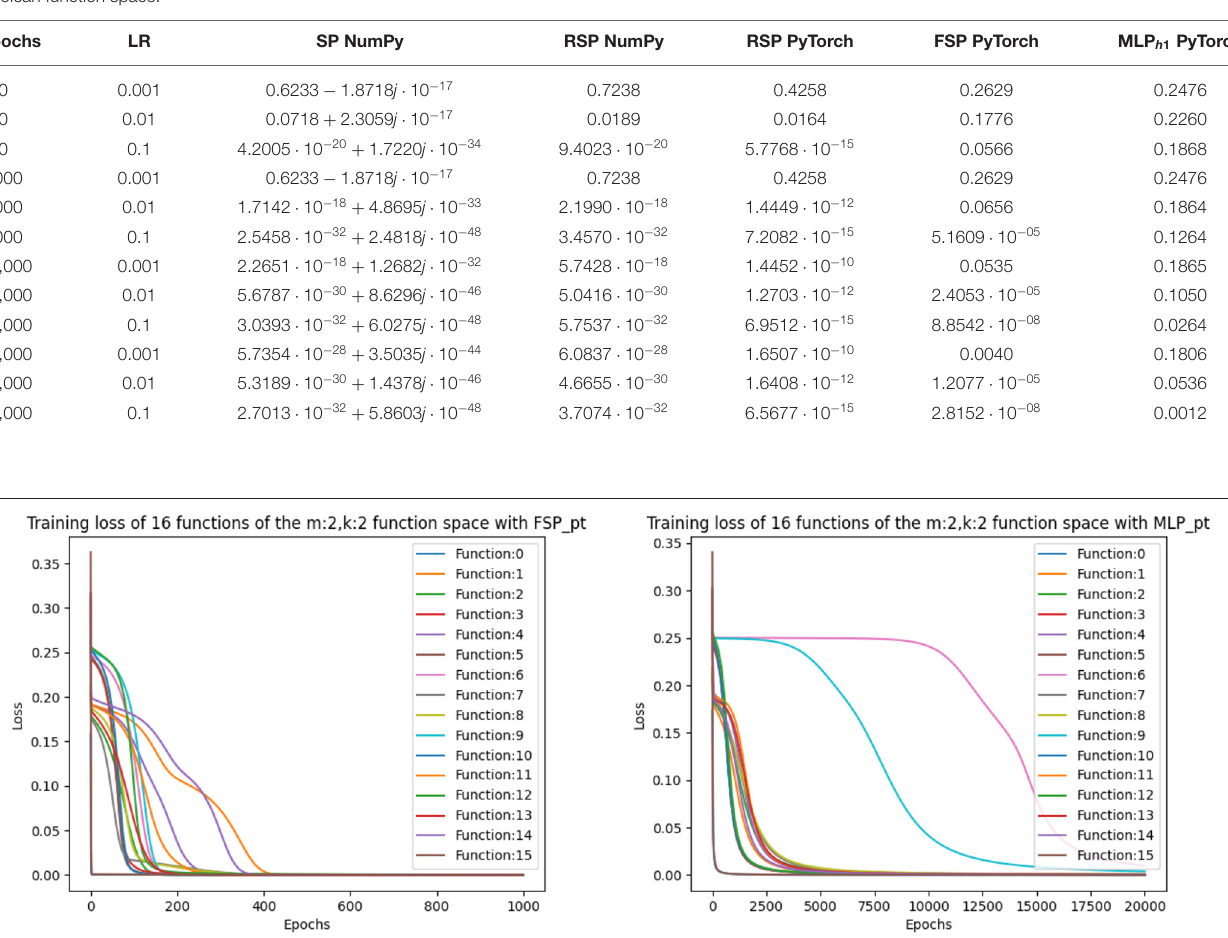
TABLE 6 | Average final loss for different implementations of the signal perceptron and MLP with one hidden layer when learning the sixteen functions of the binary Boolean function space.